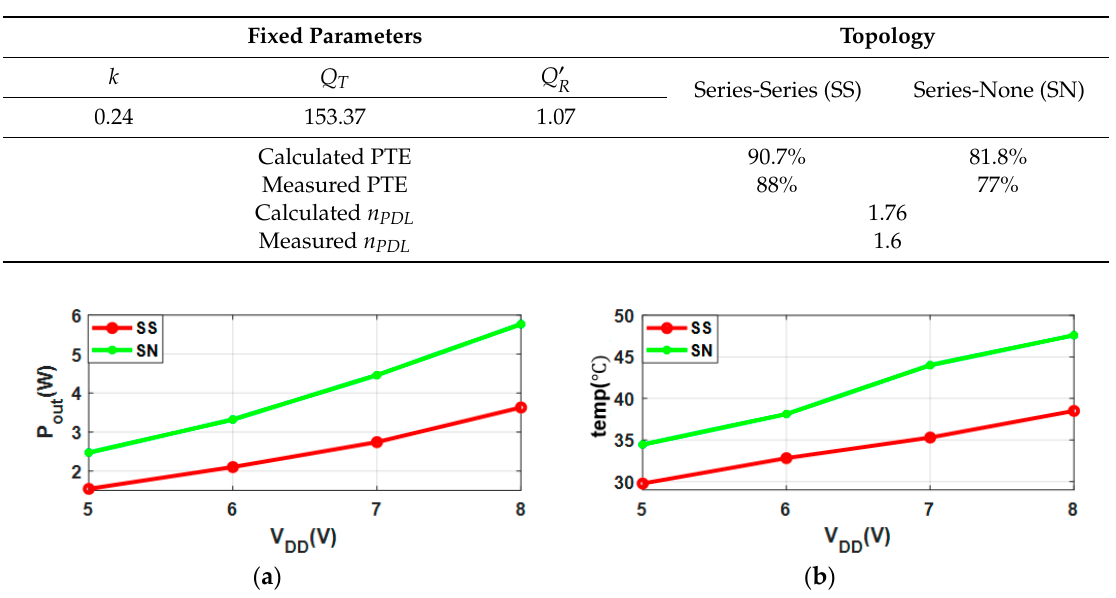
Table 2. Calculated and measured results for SS and SN modes in wearable heater.